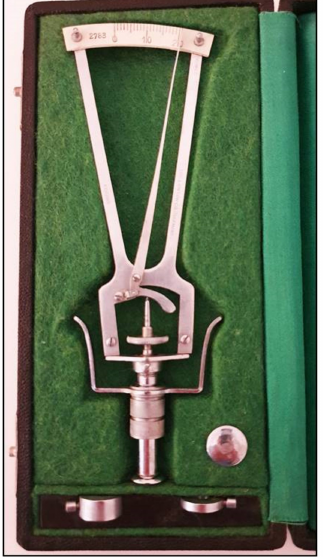
Figure 1. Schiøtz tonometer with different